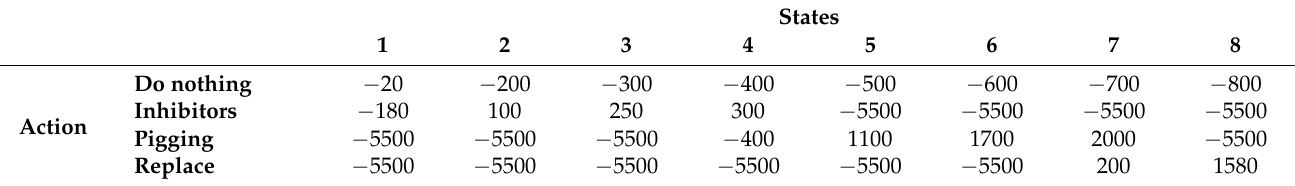
Table 5. Reward function